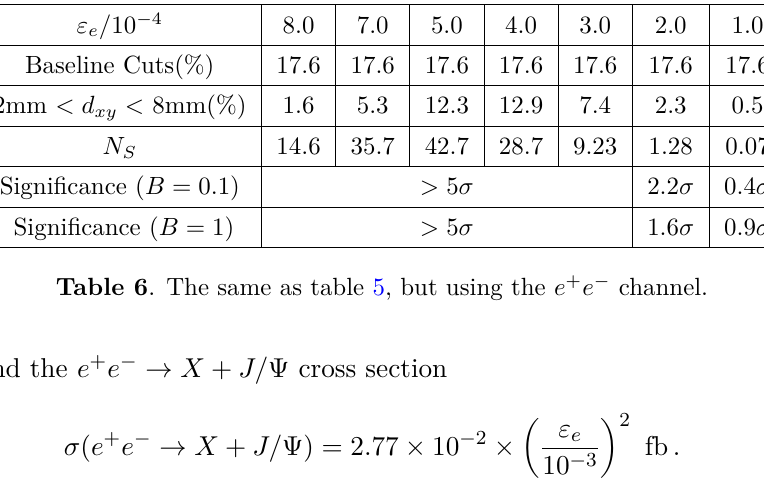
Table 5 . (From top rows to bottom) The fraction of events (in %) that survive the baseline cuts mentioned in section 4, and the flight distance 2 mm ≤ d 17 MeV X boson; the number of signal events N luminosity; and the expected significances assuming 1 event, and 0.1 event of the SM background in the analysis channel after all cuts.